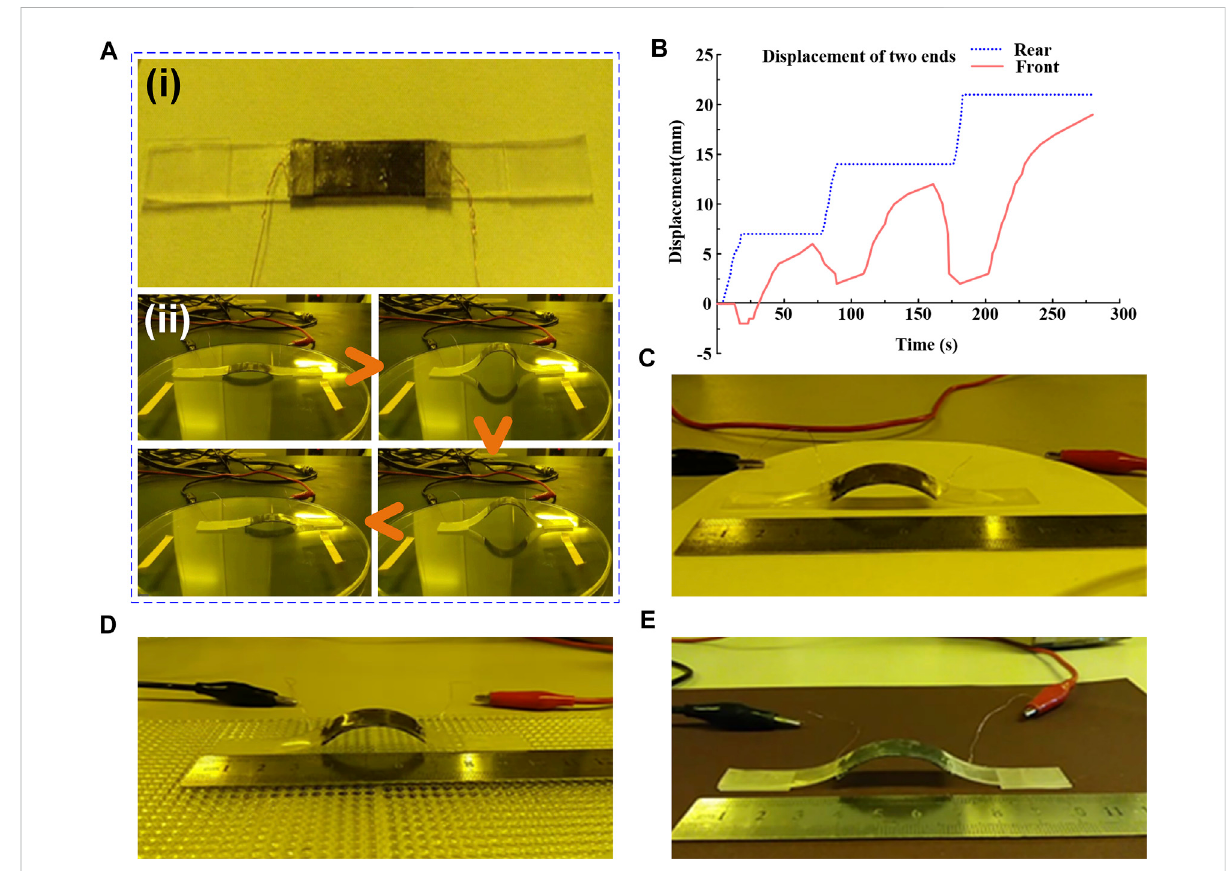
FIGURE 7 The crawling process and performance test of the inchworm-inspired soft robot. (A) Physical image of the robot and screenshots of the robot crawling on the Petri dish ’ s surface. (B) The displacement-time image of the robot crawling on the Petri dish ’ s surface. (C) Snapshot of the robot crawlingonthesurfaceofthe fi lterpaper. (D) Snapshotoftherobotcrawlingonthesurfaceofplexiglasswithaconvexsphericalarray (E) Snapshotof the robot crawling on the sandpaper